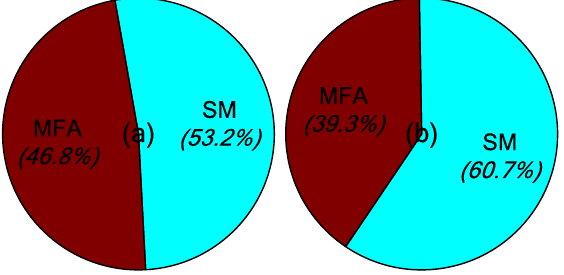
Figure 21. The contribution percentages of various methods to feedback gain: ( a ) Actuators a / b , ( b ) actuator c .